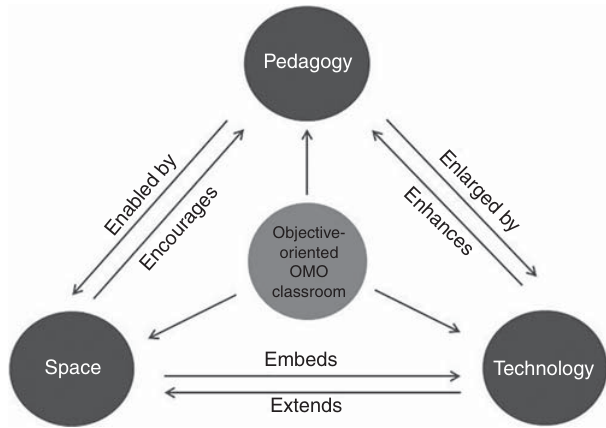
Figure 1. Online-merge-offline classroom framework based on